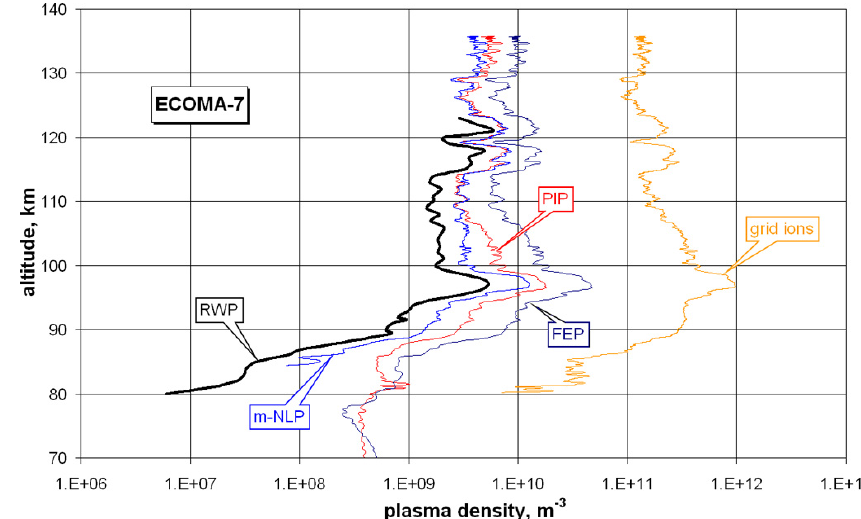
Fig. 3. Nominal (uncalibrated) plasma densities due to the various probes together with the absolute values RWP from the wave propagation instrument (flight ECOMA-7).